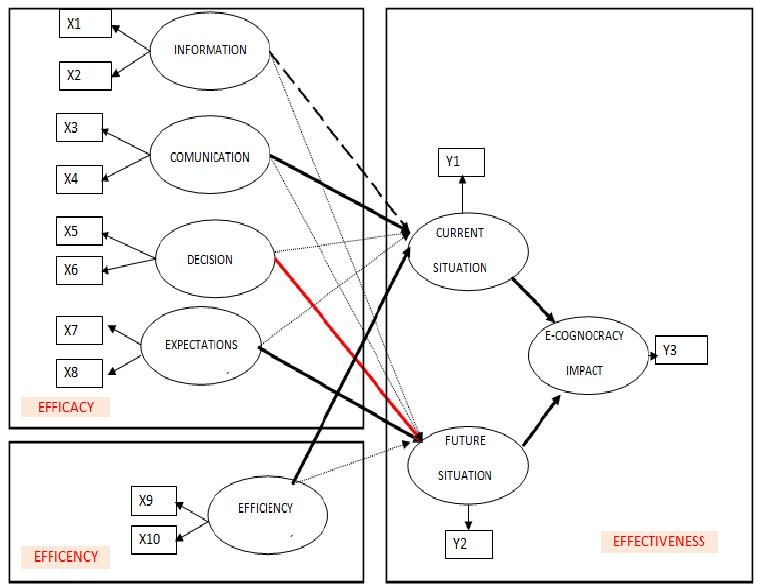
Figure 6. Estimated structural model for an EF3-evaluation of e-Cognocracy. (Source: the authors). Table 9. Structural model.